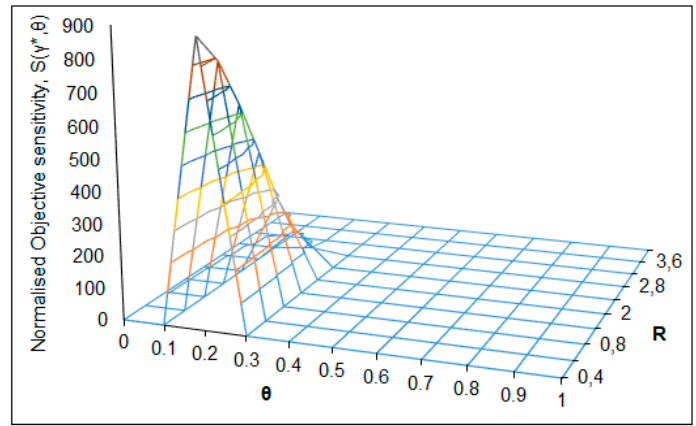
Figure 6. Normalized objective sensitivity S( γ *, θ ) as a function of parameters R and dilution rate base stream ( θ ).